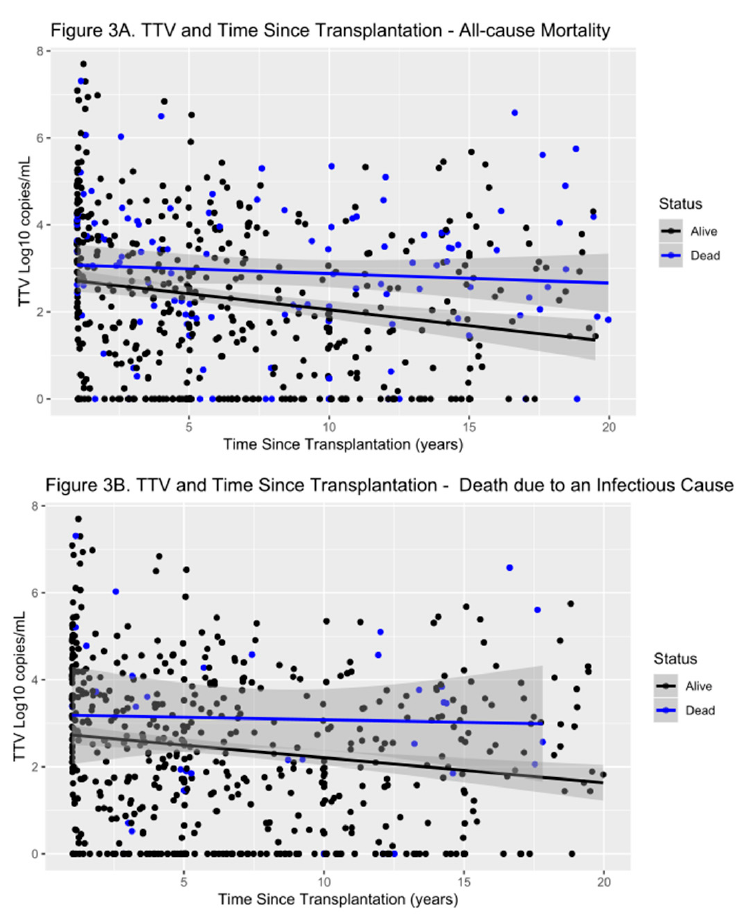
Figure 3. Scatter plot showing levels of TTV in our transplant patients and their outcomes in all-cause mortality ( A ), and death due to infectious causes ( B ). TTV levels are higher in the first years after transplantation than in later years. Patients with worse outcome show a trend of higher TTV levels over the entire follow-up period. death by all causes of due to an infectious cause (Figure